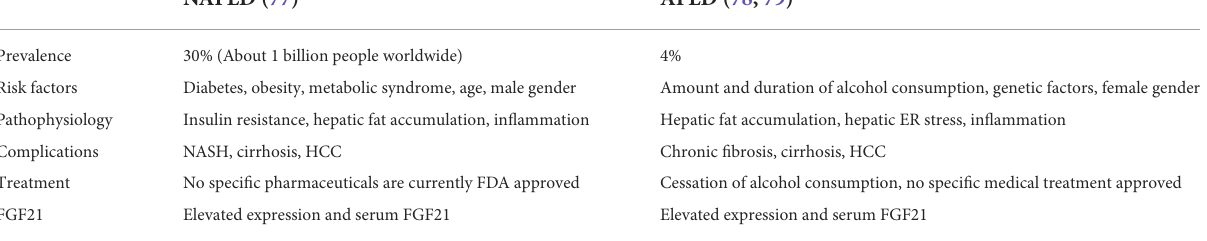
TABLE 1 The comparison table between NAFLD and AFLD. NAFLD